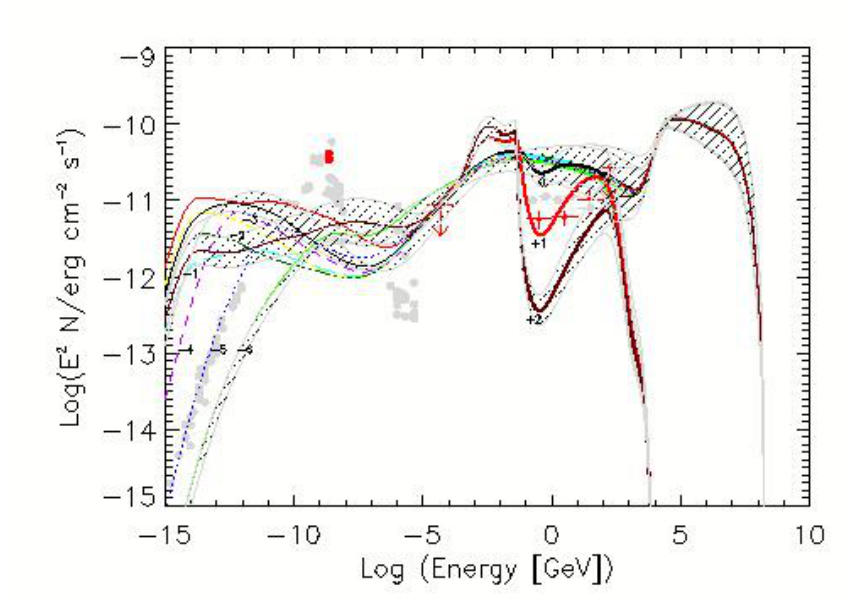
Figure 23. Simulations of synchrotron-supported cascades with target photon and proton spectra appropriate to produce the neutrino flux from TXS 0506+056 during the 2014–2015 neutrino flare, compared to contemporaneous optical, X-ray (upper limit from Swift -BAT), and GeV γ -ray ( Fermi -LAT) data. The different curves (different colors) are labelled by the log of the maximum γγ optical depth, log ( τ max γγ ) , and the shaded areas indicate error margins based on the error on the measured IceCube neutrino spectrum. All cases violate either the X-ray or γ -ray constraints. From